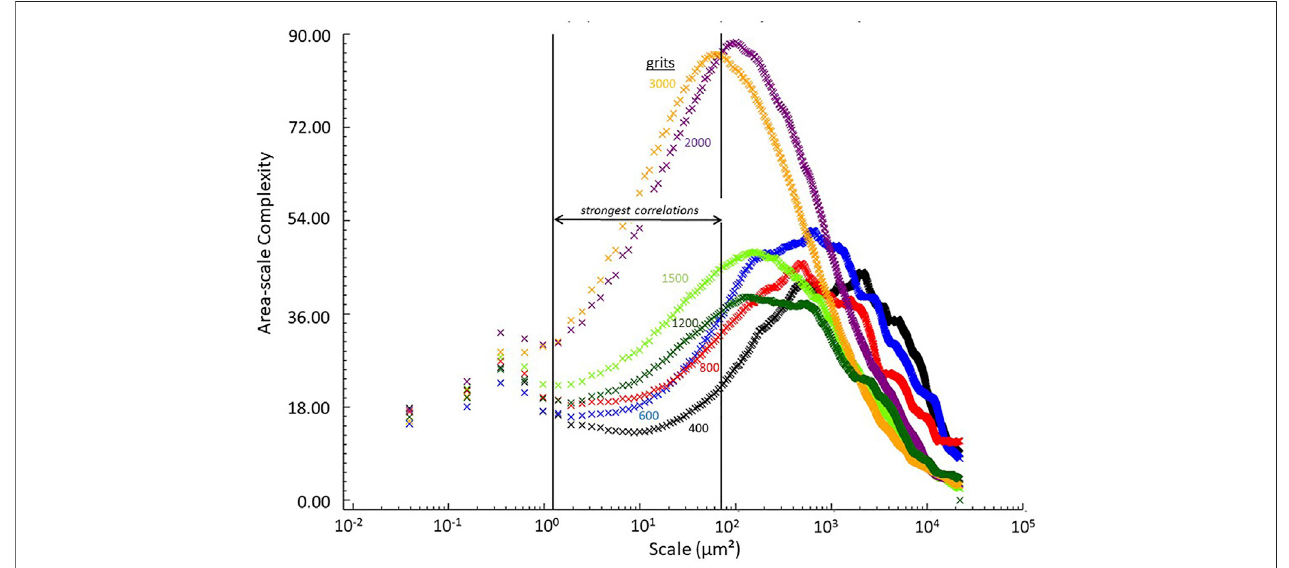
FIGURE 2 | Area-scale complexity versus scale. Grit sizes are noted on the fi gure along with the scale range for the strongest correlations of advancing contact angles regressed versus area-scale complexities.